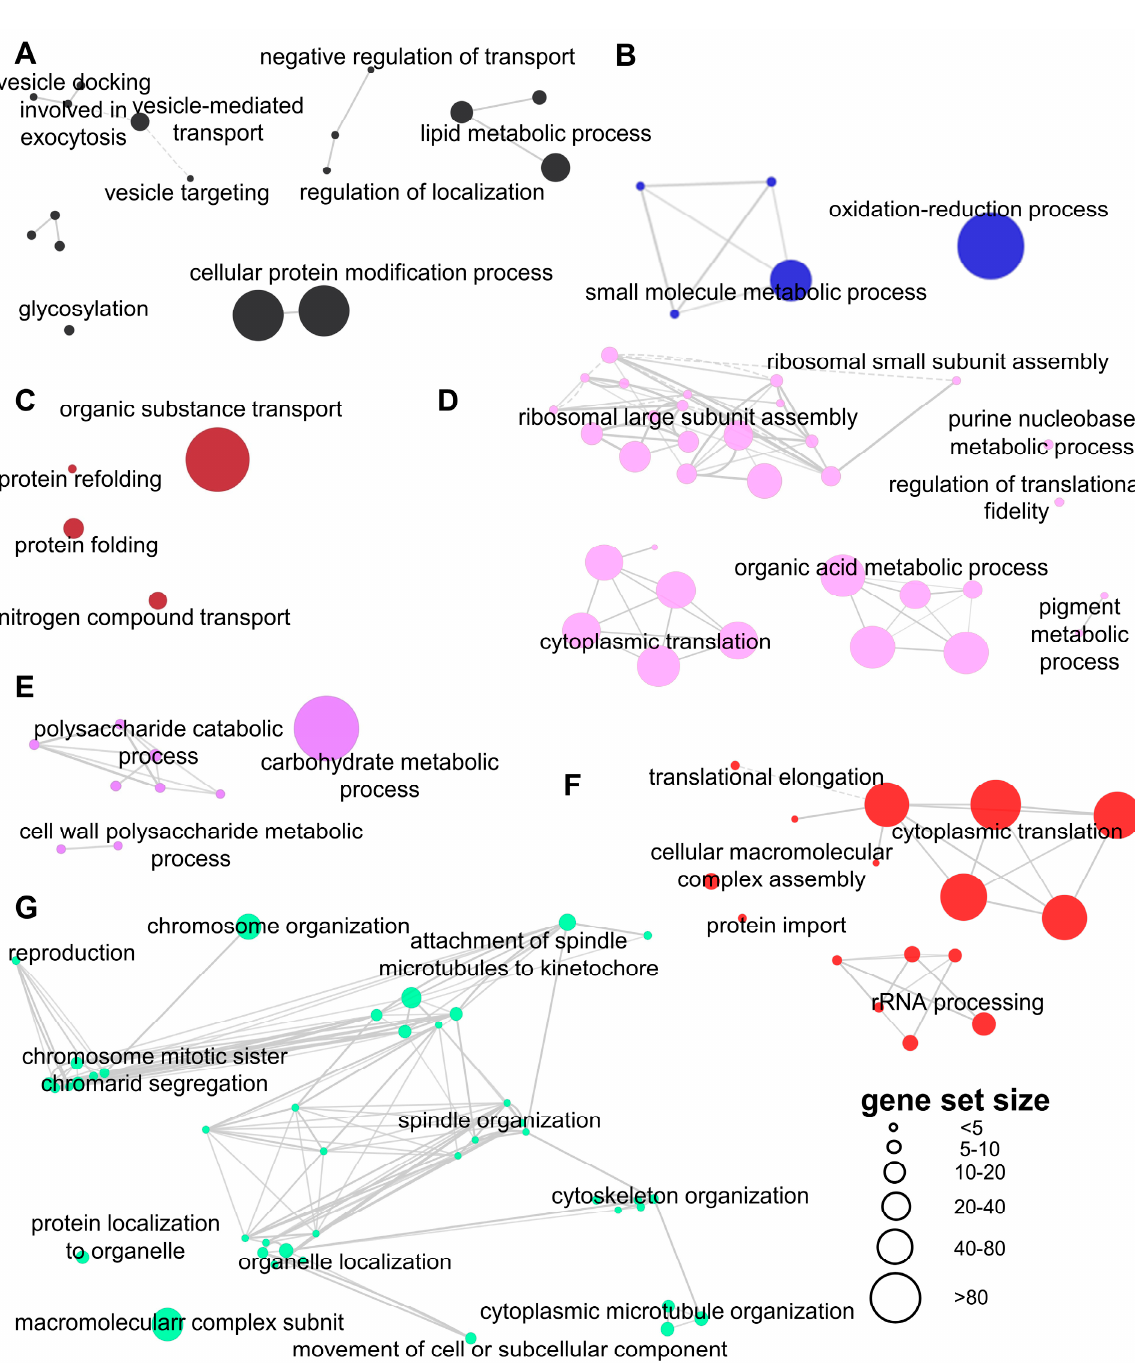
Figure 3. Biological Processes (BP) enriched in selected co-expression modules. GO enrichments in BP were analyzed for the black ( A ), blue ( B ), brown ( C ), pink ( D ), purple ( E ), red ( F ), and turquoise ( G ) modules. Corrected hypergeometric p -values < 0.001 were considered for overrepresentation. Each significantly enriched gene set is represented by a node. Node size is related to the number of genes in the gene set.